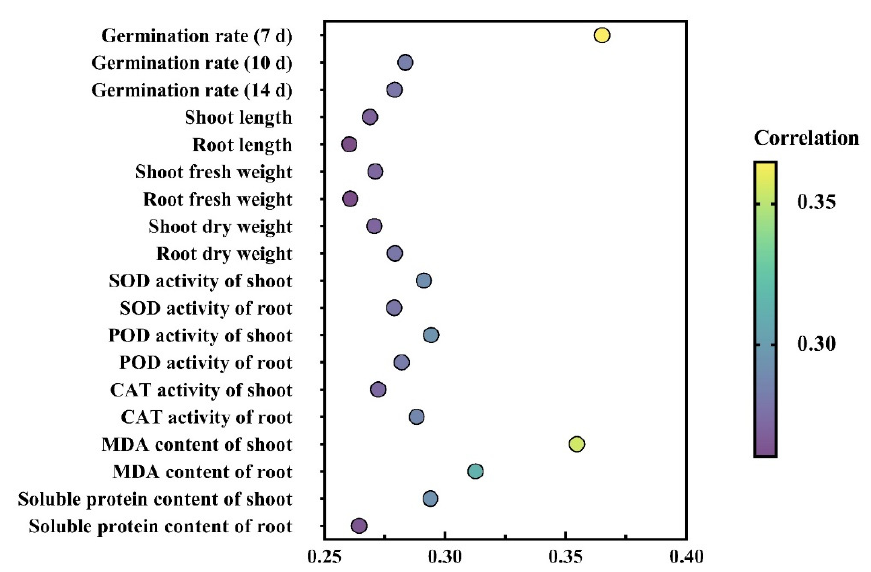
Figure 7. Analysis of the grey correlation degree between rice seed germination, seedling physiological indices, and melatonin seed soaking concentration under drought stress.